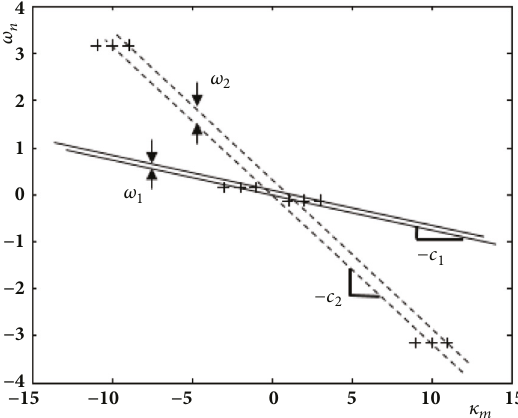
Figure 13: 𝜔 − 𝜅 diagram of the toy model